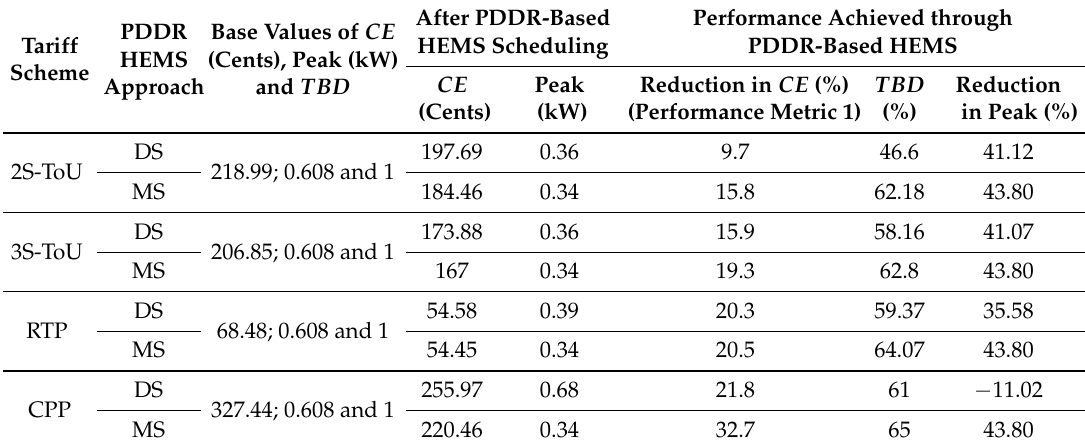
Figure 8. DWS-PSO for PDDR-based HEMS: A comparative performance for maximal reduction in CE using weights of (1,0) Table 5. DWS-PSO for PDDR-based HEMS: reductions in CE , peak load and TBD for a diversified set of